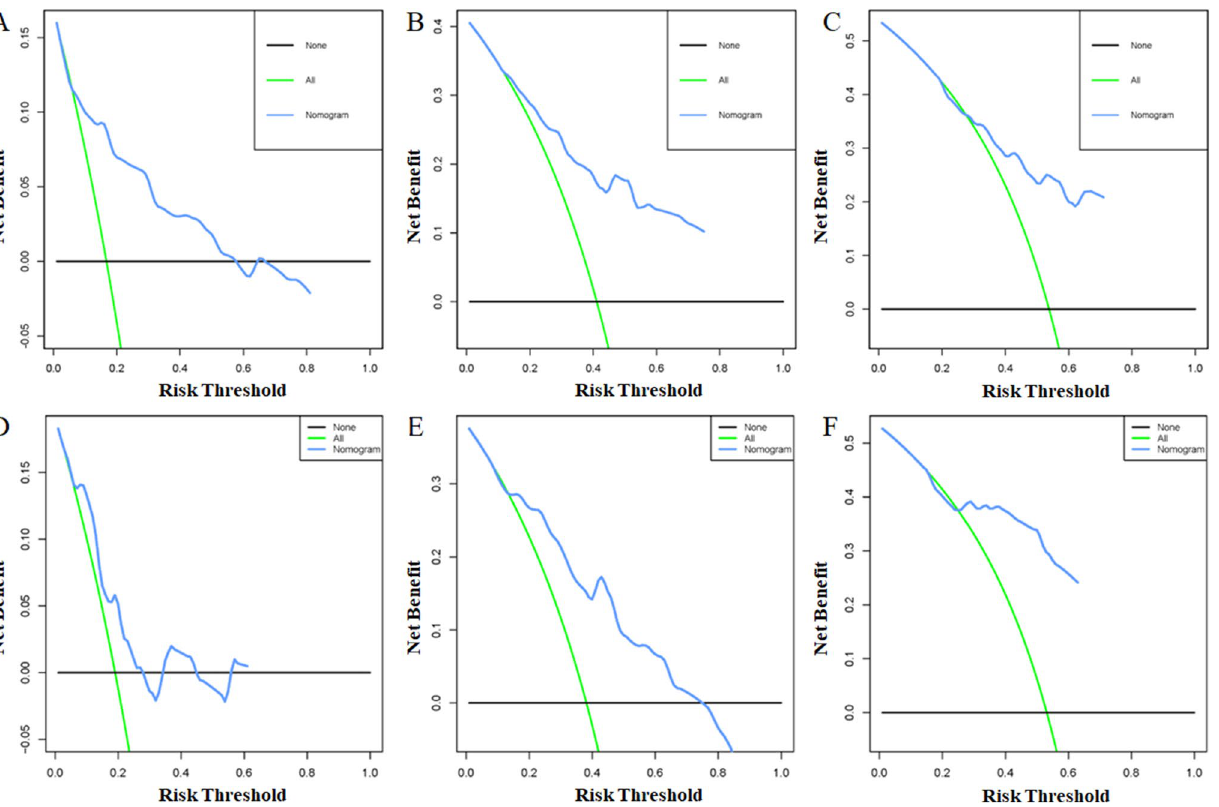
Figure 6. DCA of the nomogram for predicting the 1 ( A ), 3 ( B ) and 5 ( C ) year OS in the training set and the 1 ( D ), 3 ( E ) and 5 ( F ) year OS in the validation set. Figure was generated by R software version 4.03 (http:// www.r- proje ct. org/).